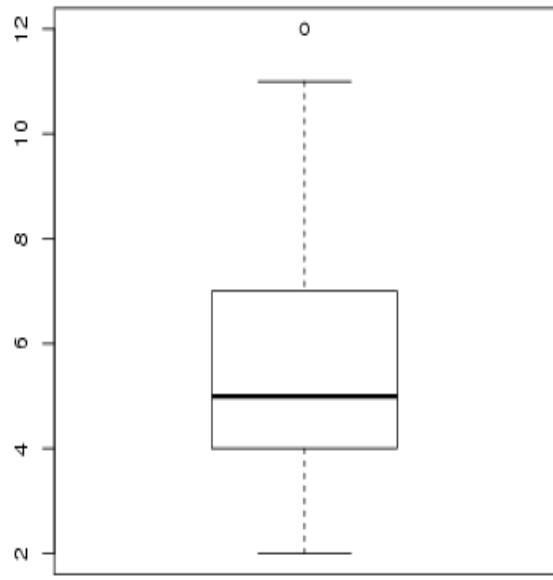
Figure 4. Box plot of the wind speed variable ( Y )